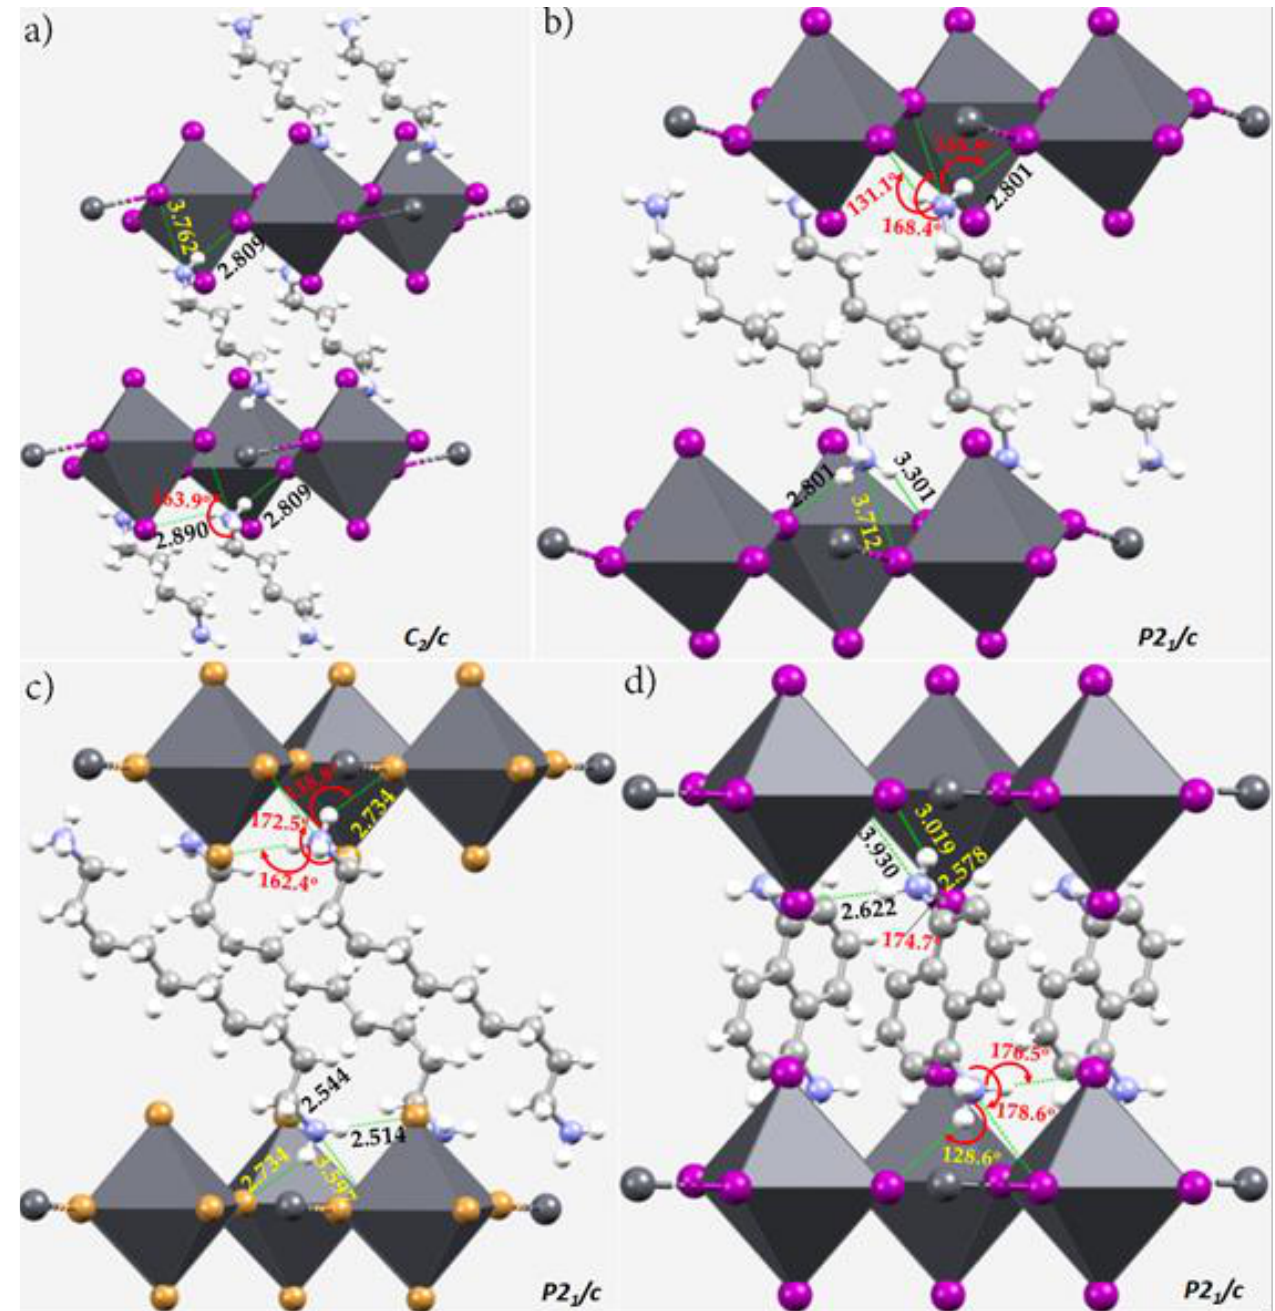
Figure 15. Mixed polyhedral (inorganic) and ball-and-stick (organic) models of the crystals of ( a ) (H 3 N(CH 2 ) 4 NH 3 )PbI 4 ] ( b ) (H 3 N(CH 2 ) 8 NH 3 )PbI 4 ] ( c ) (H 3 N(CH 2 ) 10 NH 3 )PbBr 4 ] and ( d ) (H 3 NC 10 H 6 NH 3 )PbI 4 , reported by Lemmerer and Billing [110]. Bond lengths and bond angles associated with selected intermolecular interactions are in Å and degrees, respectively. Space groups are shown for each case. Intermolecular interactions are marked as dotted lines in green. The structure of (NH 3 (CH 2 ) 12 NH 3 ) n PbI 4 · n (PbI 4 ) (Figure 14c) has been reported by two